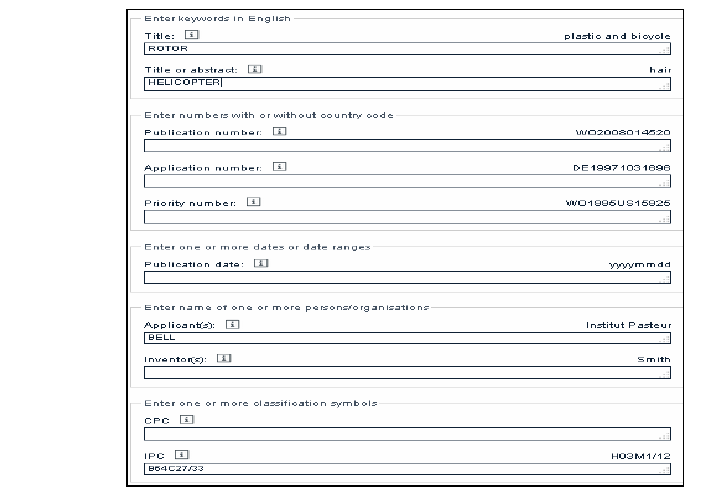
Рис . 5 – Расширенный поиск по названию , ключевым словам , заявителю и